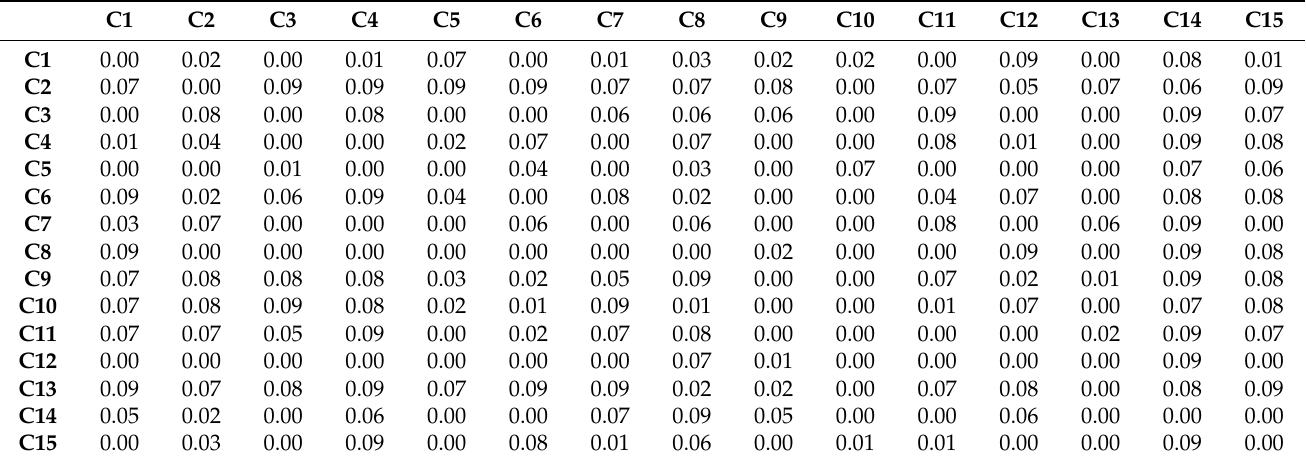
Table 5. Normalized